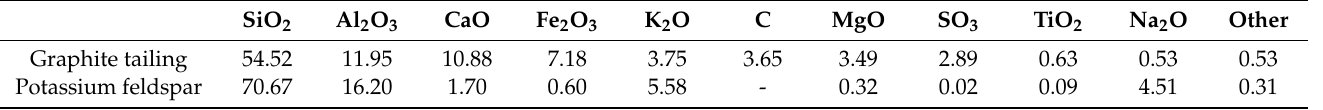
Table 1. Chemical composition of graphite tailings and potassium feldspar